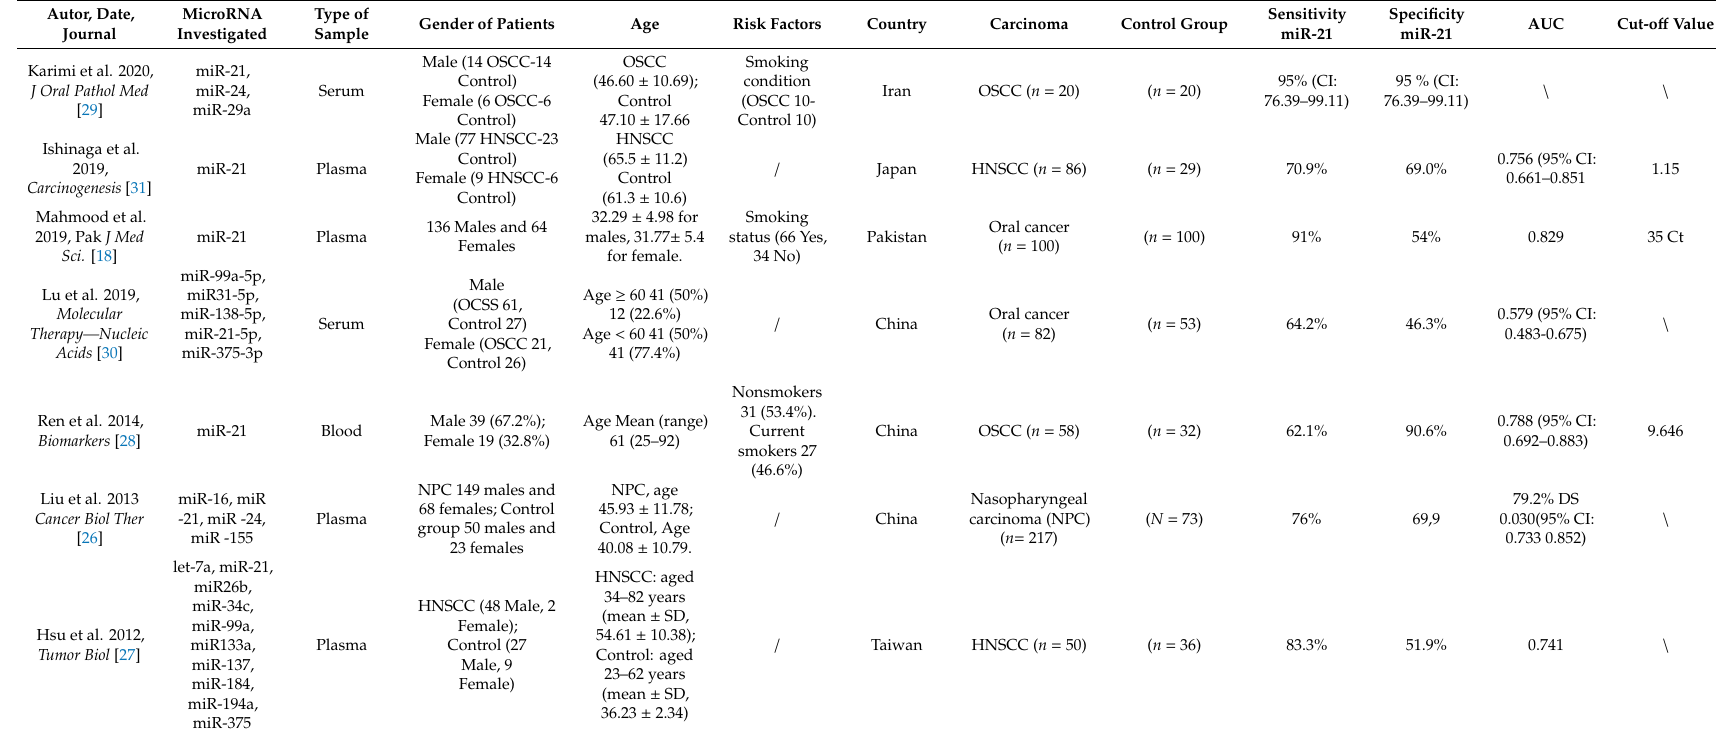
Table 3. The data extracted for the six articles included in the